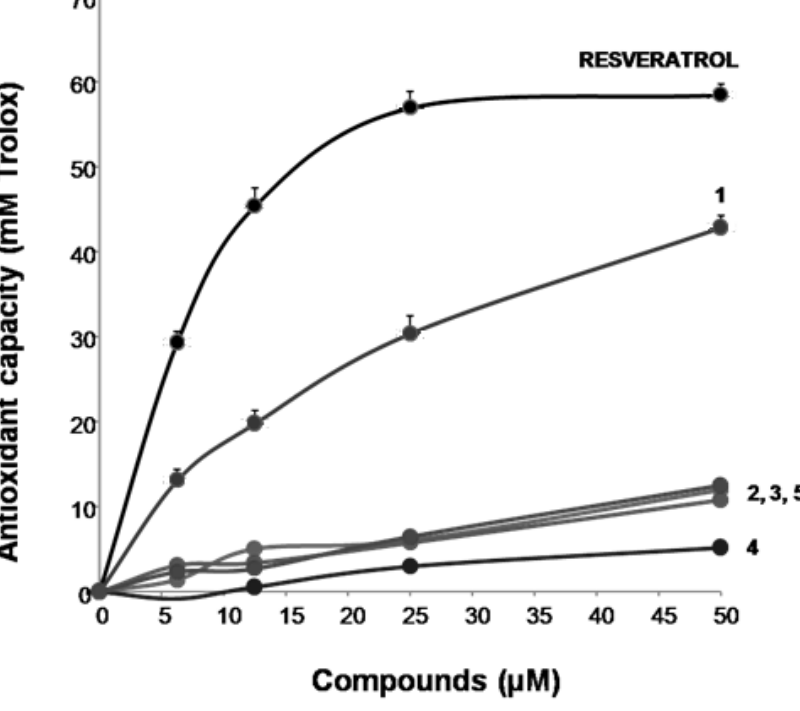
Figure 3. Antioxidant properties of compounds 1 – 5 (ORAC